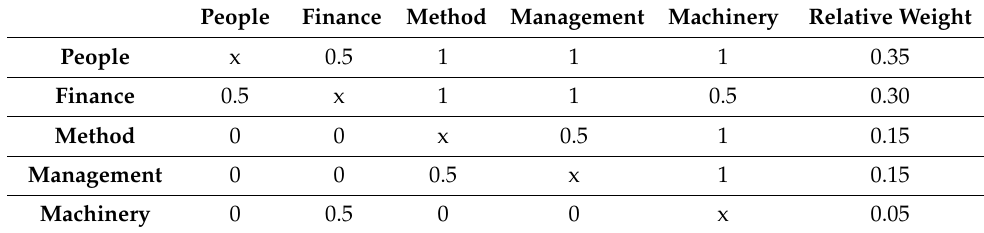
Table 2. Significance weights of the main categories.